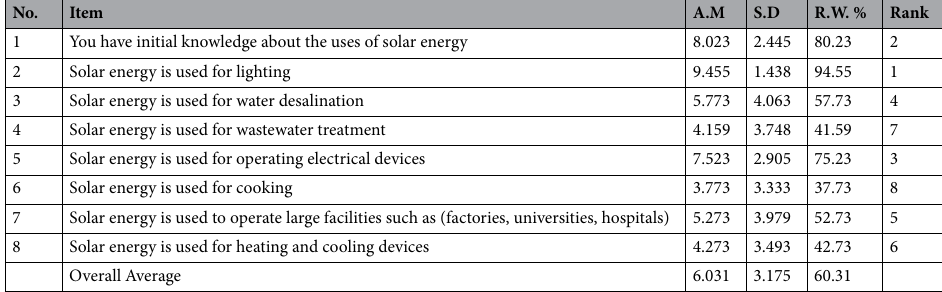
Table 1. Participants knowledge about solar energy assessment by using A.M., S.D. and R.W